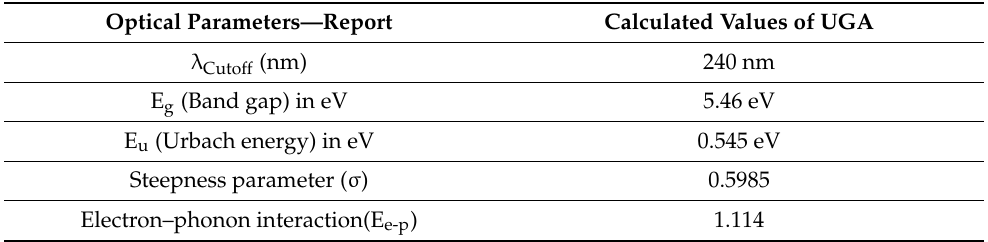
Table 2. Calculated optical parameters of UGA.